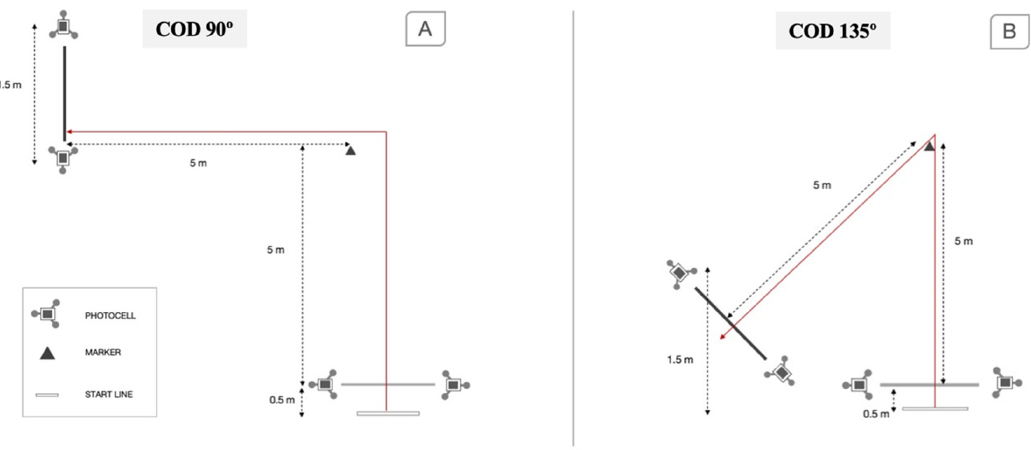
Figure 1. Schematic representation of the change direction tests, 90° ( A ) and 135° ( B ).